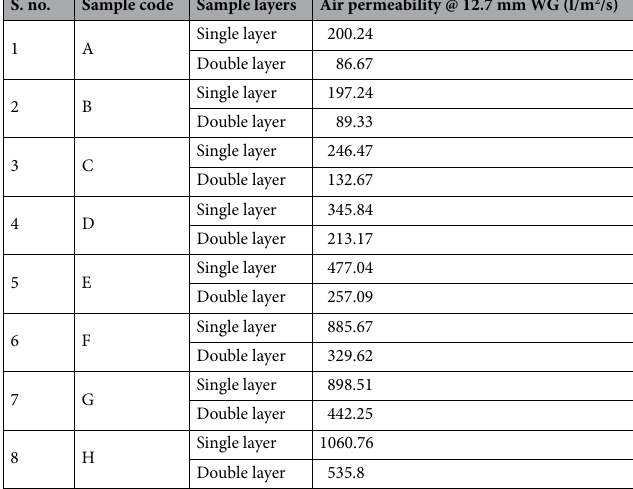
Table 2. Air permeability of PPE melt blown non woven samples as per ASTM D73.